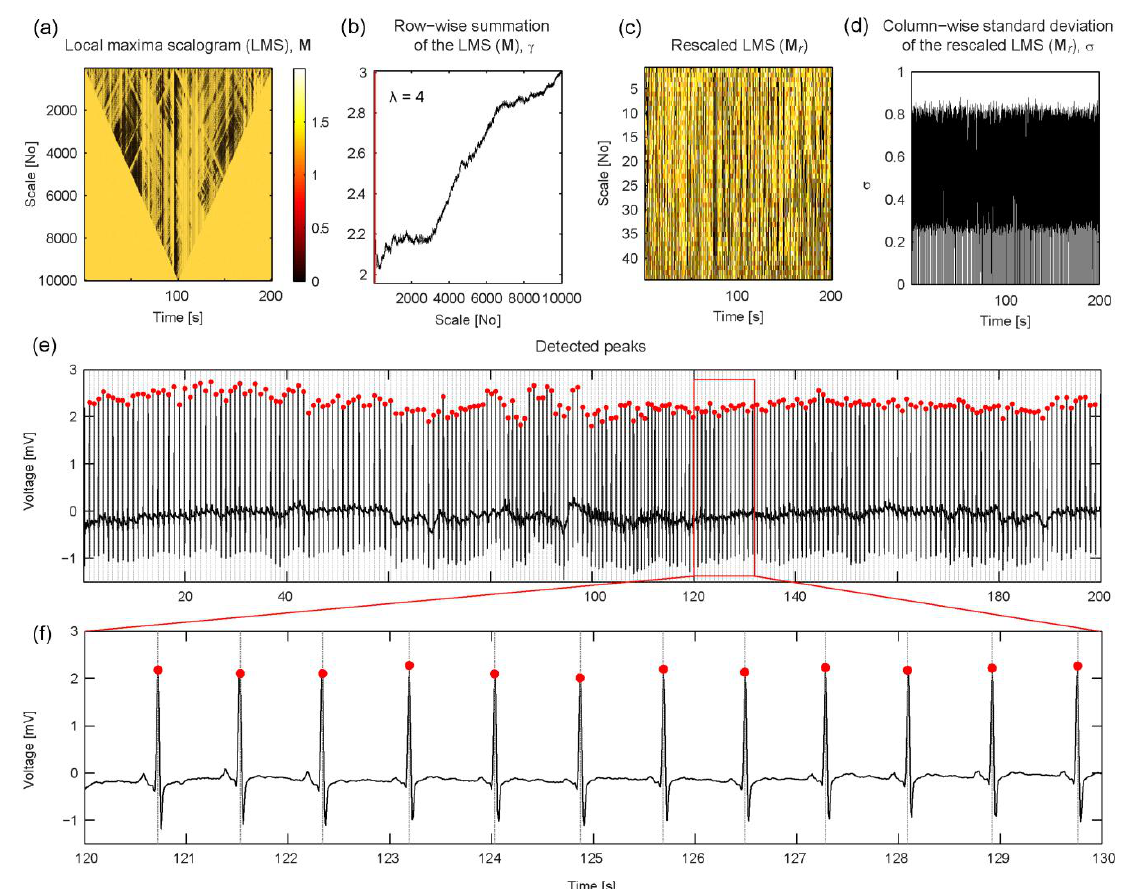
Figure 8. Results of applying the AMPD algorithm to an ECG time